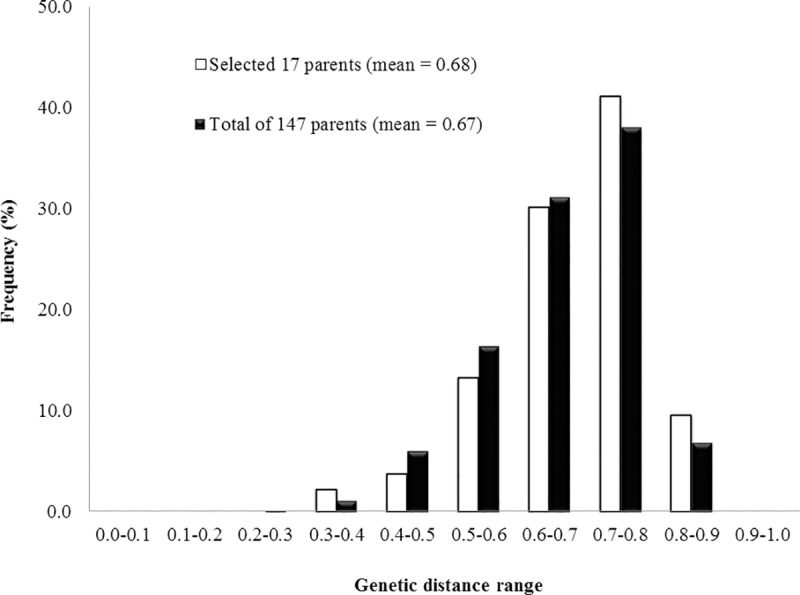
Frequency distribution of genetic distances of all the 147 hybrid parents and for the selected representative set of 17 parents using SSRs.